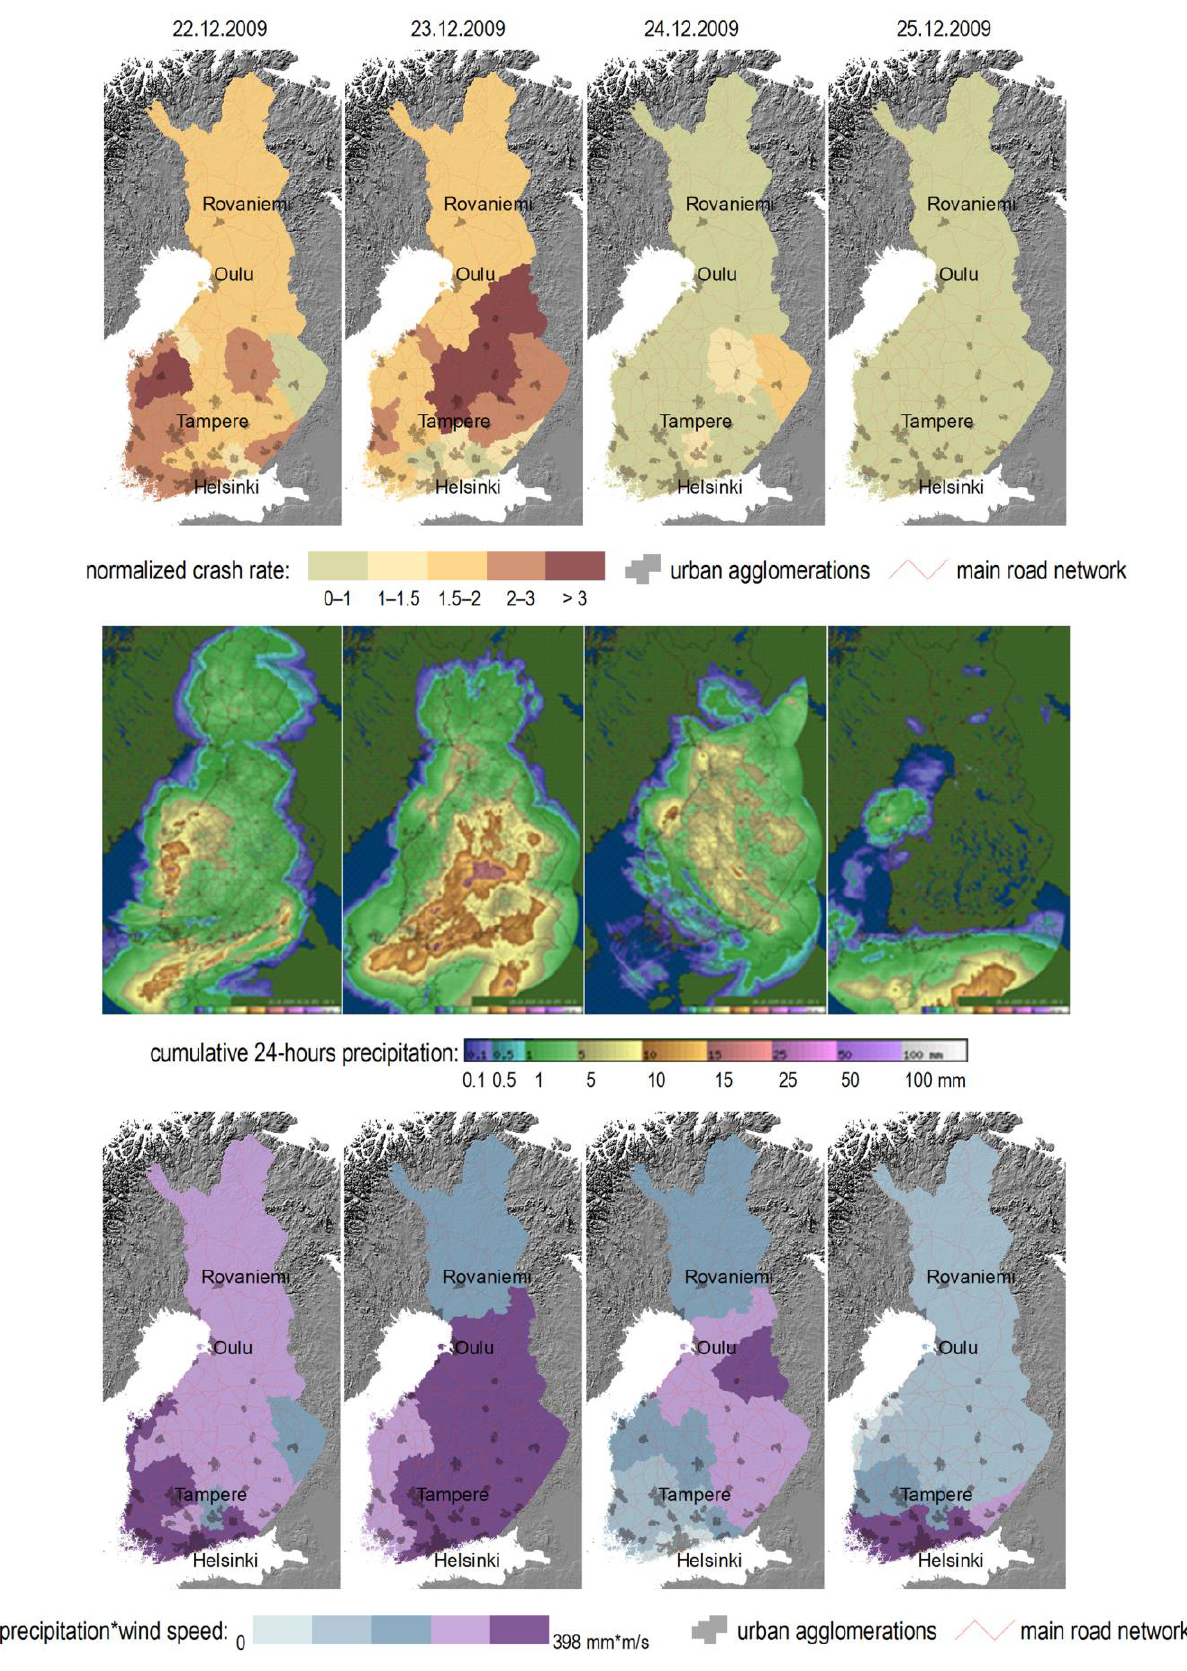
Figure 4. An example of spatiotemporal association between crash rates and severe